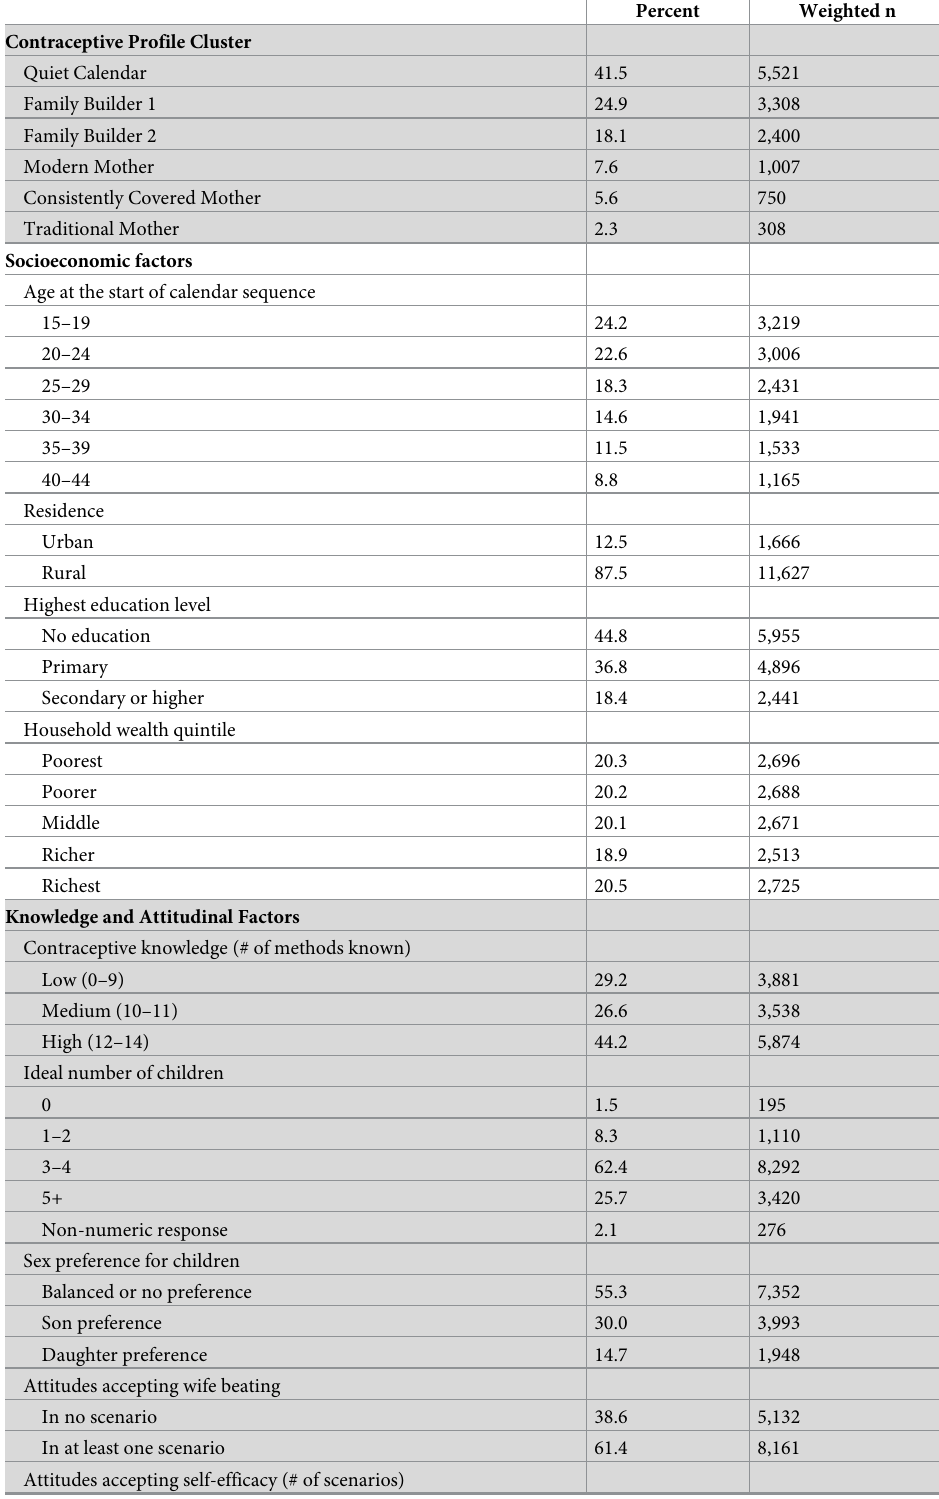
Table 1. Analytic sample